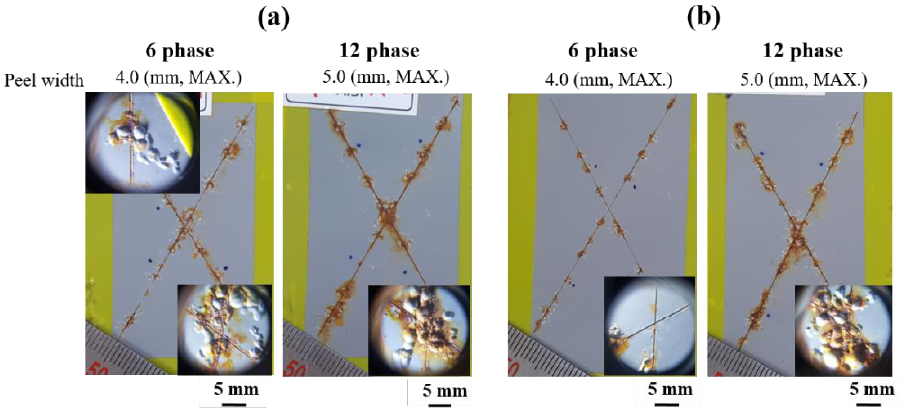
Figure 11. Surface appearance of electrodeposited (ED)-treated ( a ) AlSi-MC and ( b ) AlSiZnMg-MC, which had been scratched with an “×” incision, after the accelerated corrosion test.